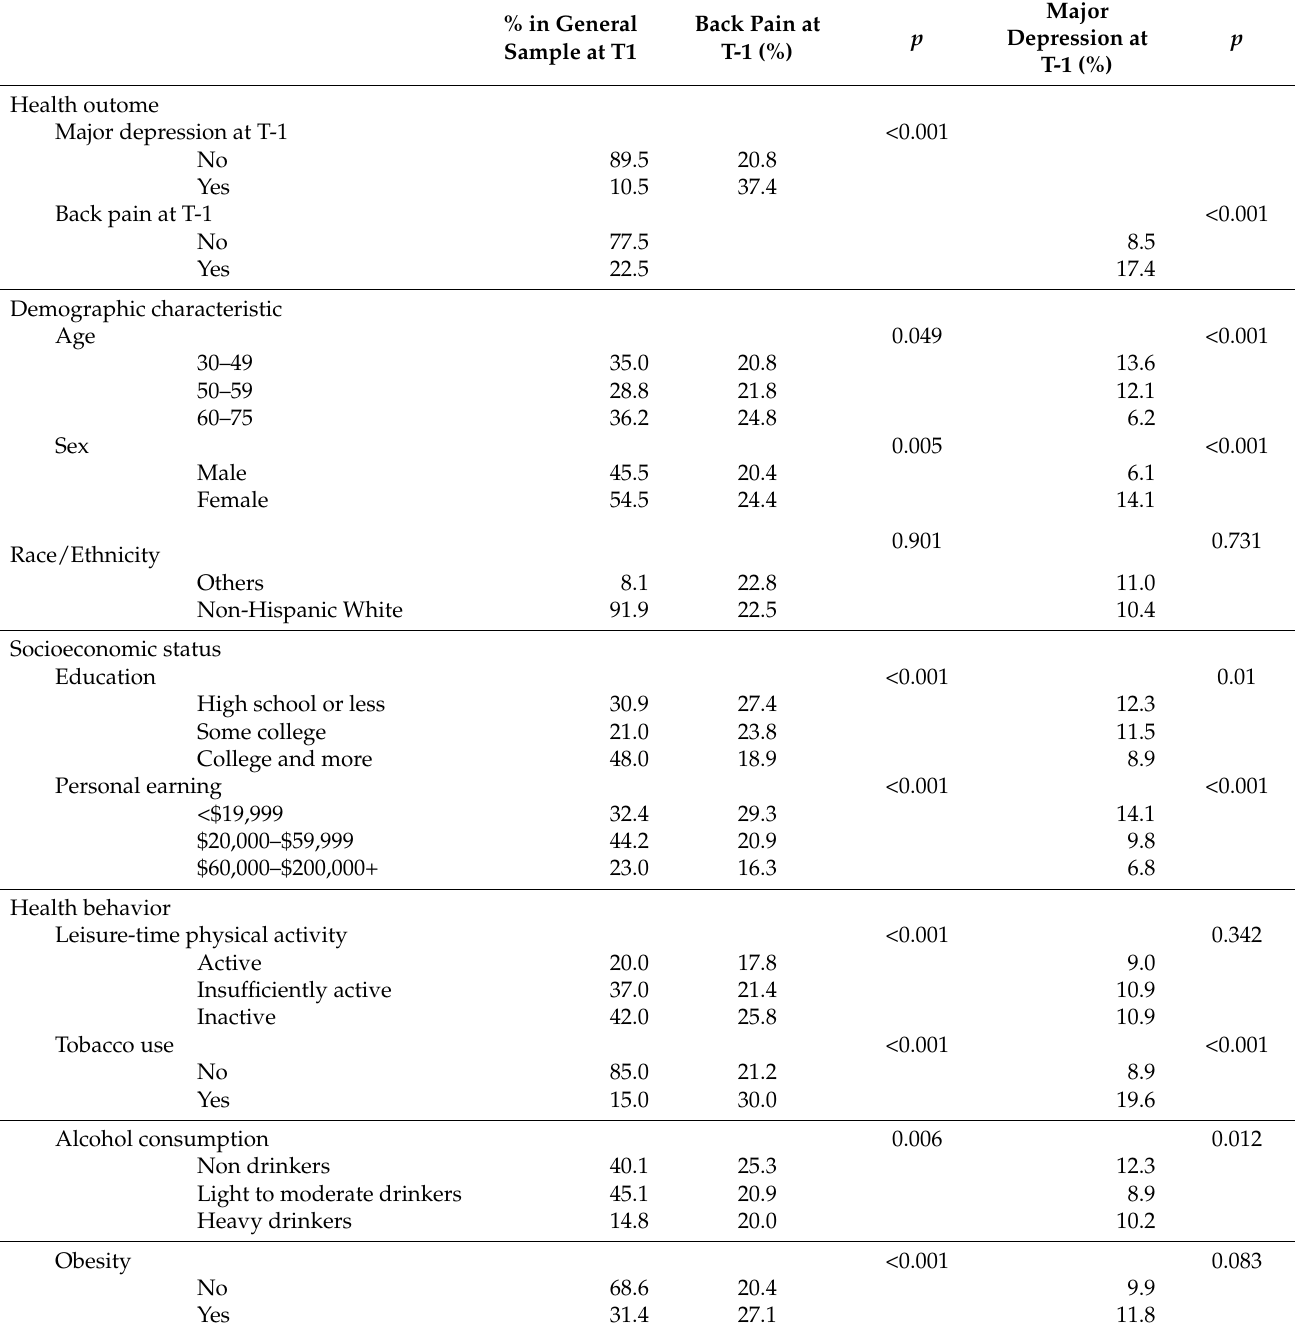
Table 1. Prevalence of major depression and back pain at T-1 by characteristics of the study sample at T-1.